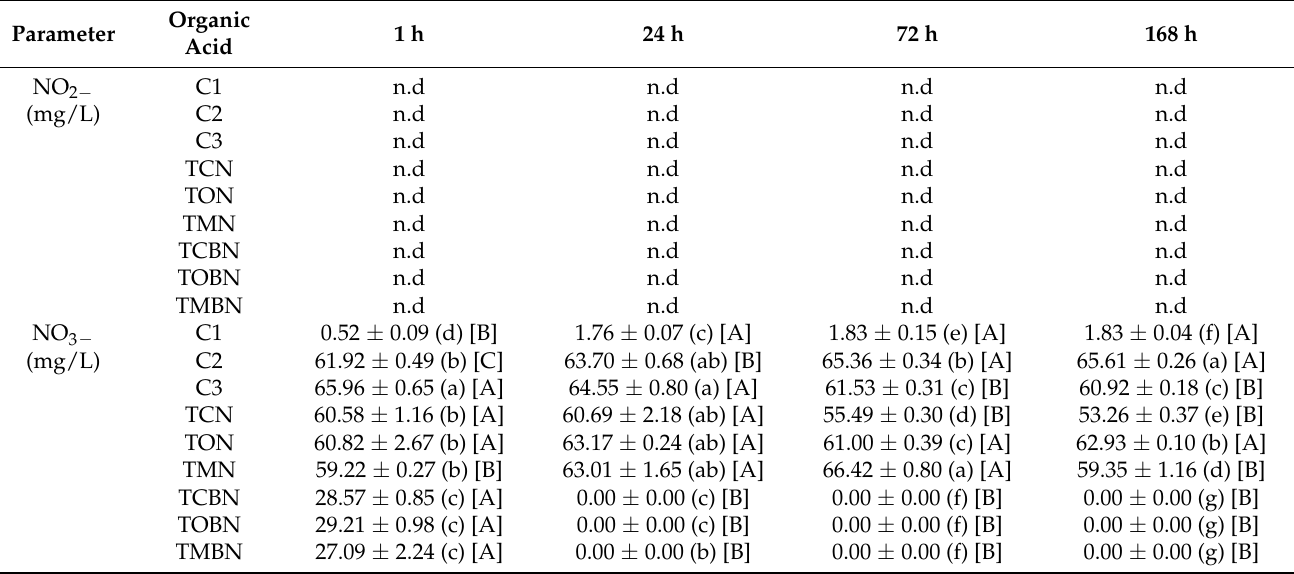
Table 2. Nitrite and nitrate in the solutions collected at different times during the experiment for the controls and treatments.